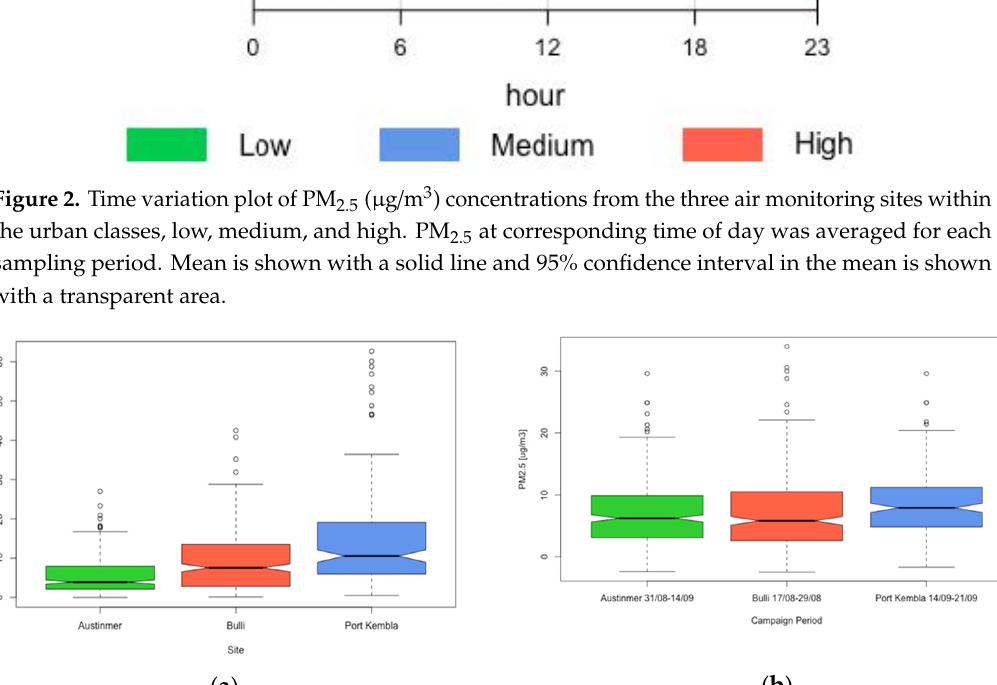
Figure 3. ( a ) Notched boxplots of PM 2.5 ( μ g/m 3 ) hourly concentrations from each of the three air monitoring site locations. Austinmer was low urbanisation, Bulli was medium, and Port Kembla was highly urbanised. ( b ) Notched boxplot of PM 2.5 ( μ g/m 3 ) hourly concentrations from the Office of